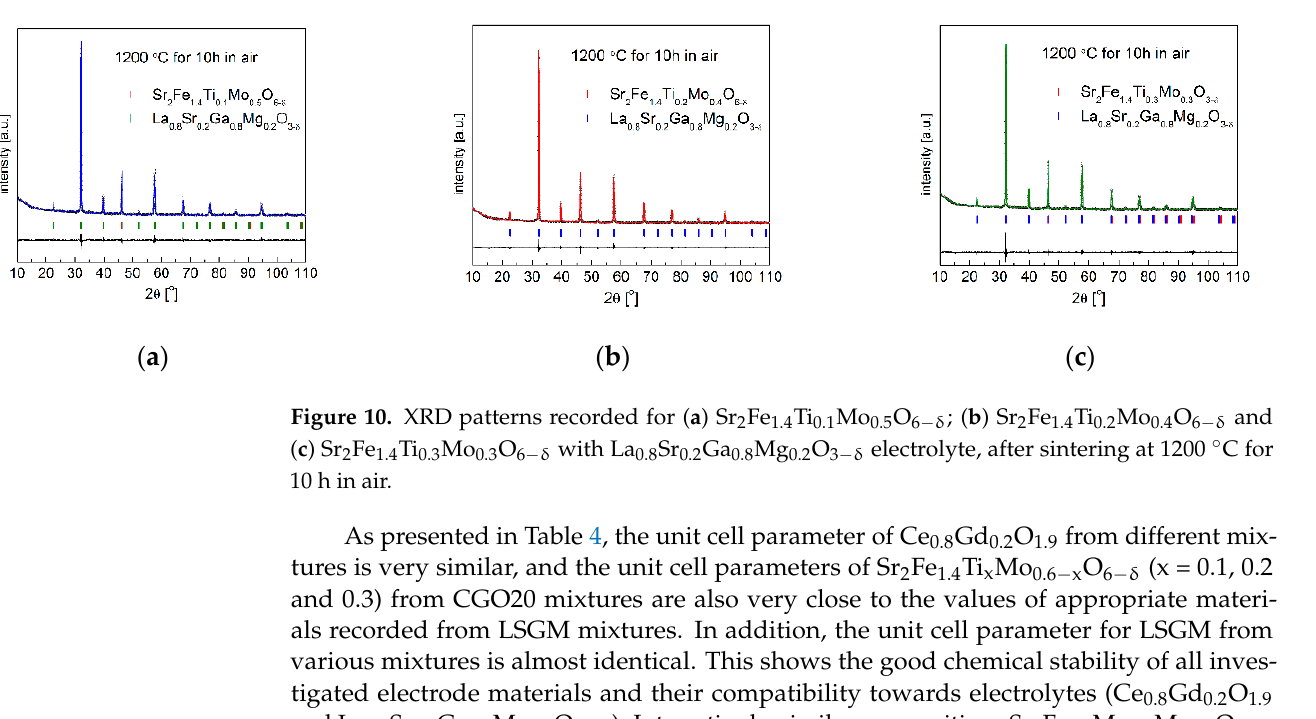
Figure 9. XRD patterns recorded for ( a ) Sr 2 Fe 1.4 Ti 0.1 Mo 0.5 O 6 − δ ; ( b ) Sr 2 Fe 1.4 Ti 0.2 Mo 0.4 O 6 − δ and ( c ) Sr 2 Fe 1.4 Ti 0.3 Mo 0.3 O 6 − δ with Ce 0.8 Gd 0.2 O 1.9 electrolyte, after firing in air at 1200 ◦ C for 10 h.